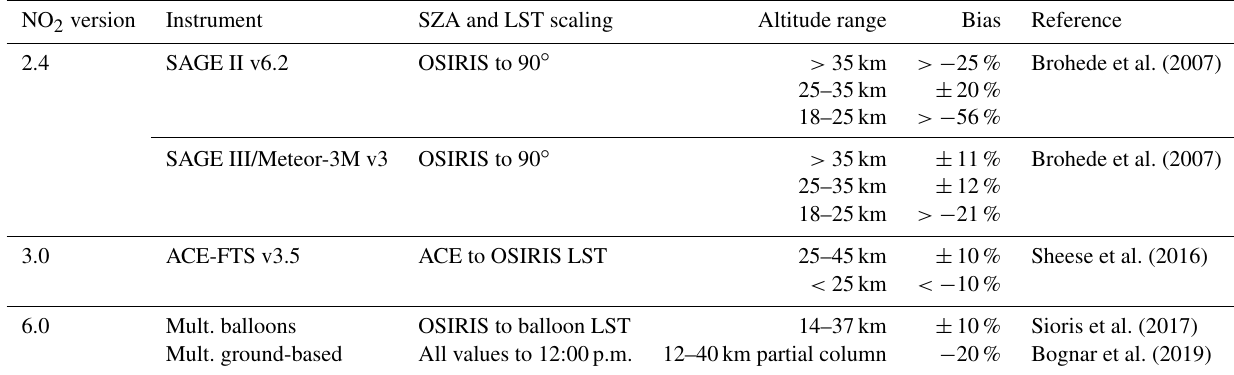
Table 1. Summary of validation results for prior versions of the OSIRIS NO 2 retrieval. The SZA and LST scaling column describes how the different measurement times of the instruments were accounted for. A negative bias means that OSIRIS is biased